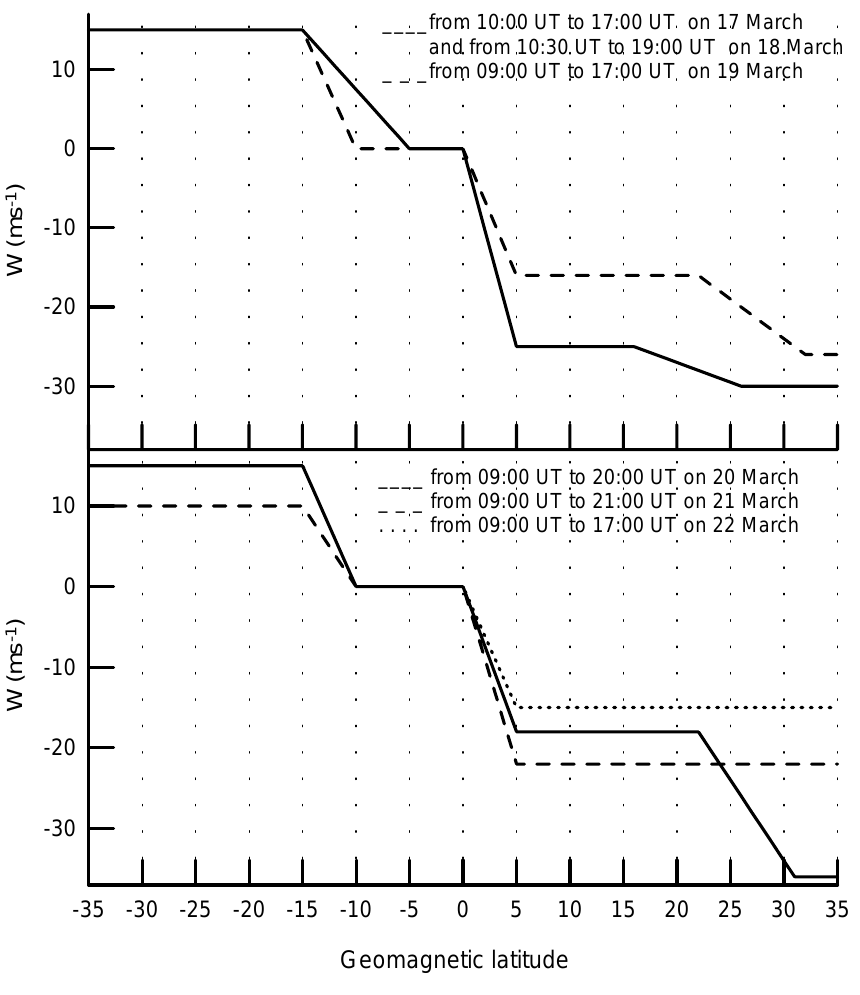
Fig. 8. The latitude distributions of the meridional neutral wind used in the model simulations instead of the HWM90 meridional neutral wind from 10:00 UT to 17:00 UT on 17 March (solid line in the top panel), from 10:30 UT to 19:00 UT on 18 March (solid line in the top panel), from 09:00 UT to 17:00 UT on 19 March (dashed line in the top panel), from 09:00 UT to 20:00 UT on 20 March (solid line in the bottom panel), from 09:00 UT to 21:00 UT on 21 March (dashed line in the bottom panel), and from 09:00 UT to 17:00 UT on 22 March (dotted line in the bottom